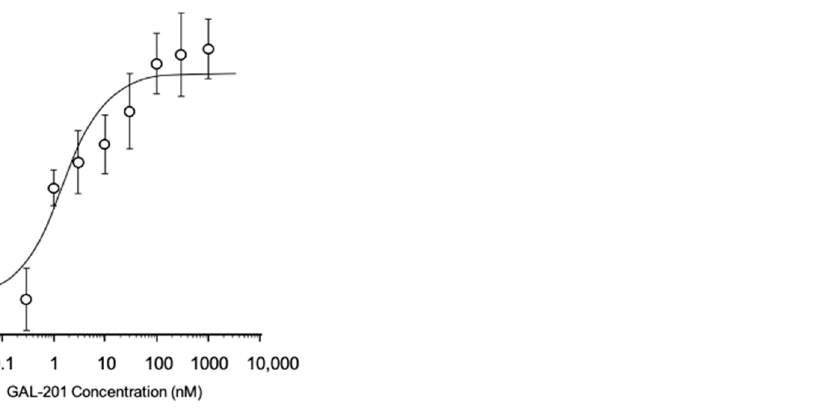
Figure 1. GAL-201 binding to A β 1-42 using surface plasmon resonance (SPR). This binding assay was performed using a Biacore X100 biosensor instrument equipped with two flow cells. A β 1-42 was covalently coupled to one flow cell of CM7 sensor chips using an amine coupling kit. HBS-EP was used as assay running buffer. The analyte GAL-201 was injected over the sensor chip in concentrations ranging from 0.3 to 1000 nM at a flow rate of 10 µL/min for 180 s at 25 °C. Responses were evaluated at steady state, plotted against concentration, and fit by the four-parameter logistic equation to a K D = 2.5 nM (n= 4). χ 2 = 6.124.